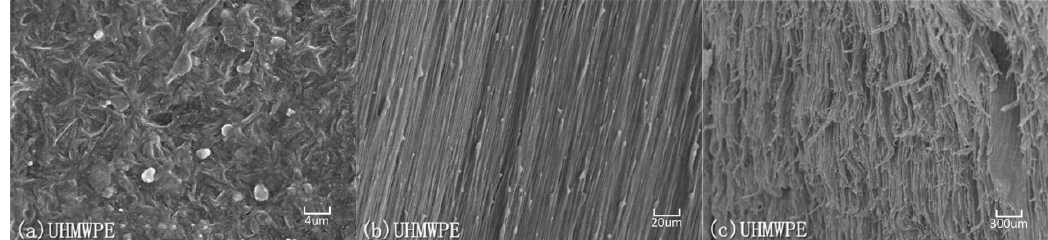
Figure 9. Electron micrographs of microstructure evolution in semi-crystalline UHMWPE under large plastic deformation: ( a ) original state, ε = 0; ( b ) highly oriented texture along the loading direction, ε = 1; ( c ) fracture surface, ε = 6.6.